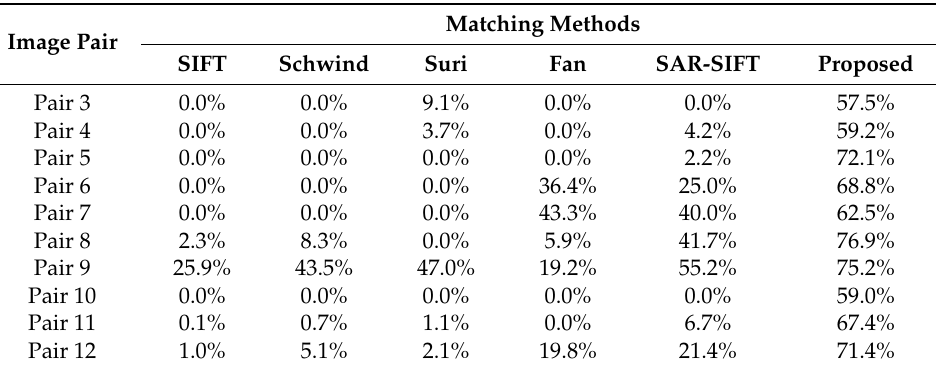
Table 11. MP values of each method for SAR and optical